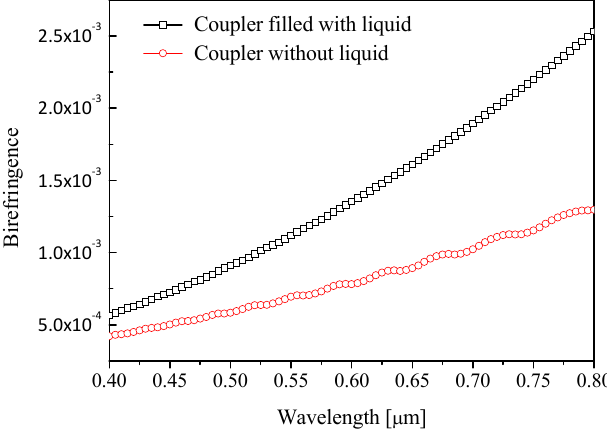
Figure 6. Birefringence as a function of filling material.